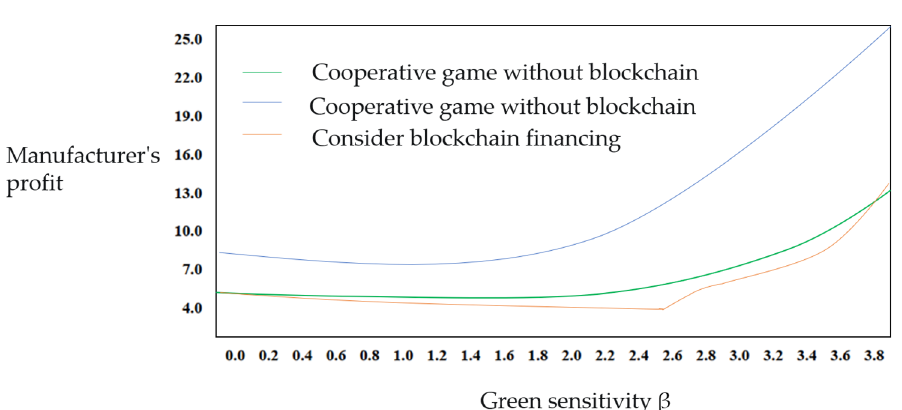
Figure 3. Retailer profit at different levels of β .